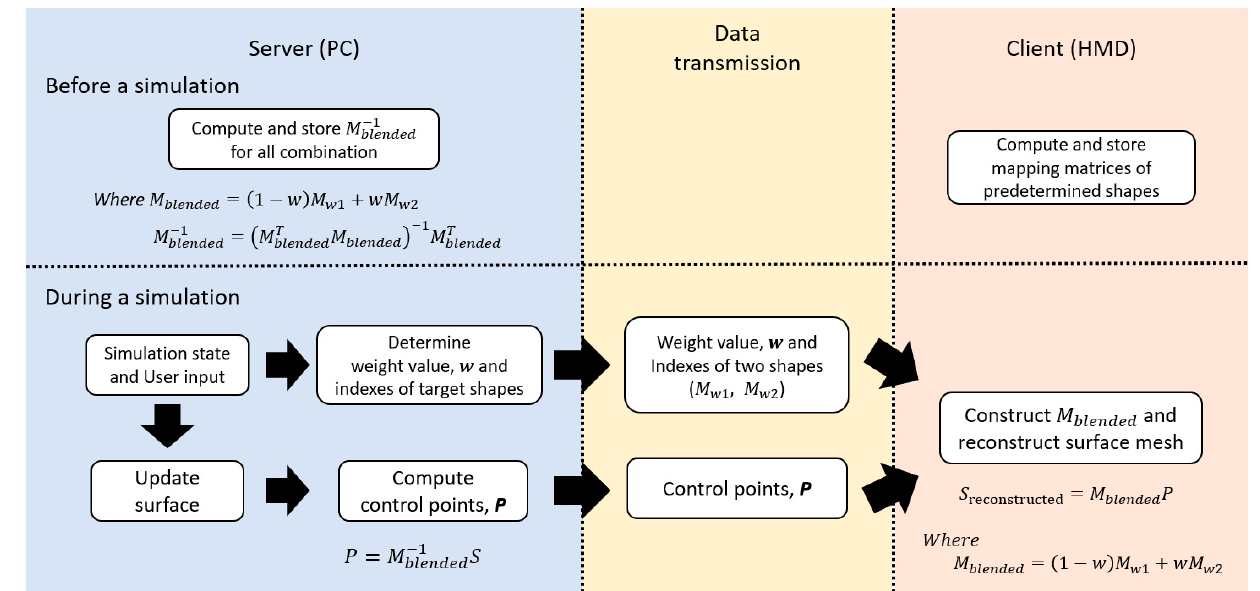
Figure 5. The overall process of the proposed framework.